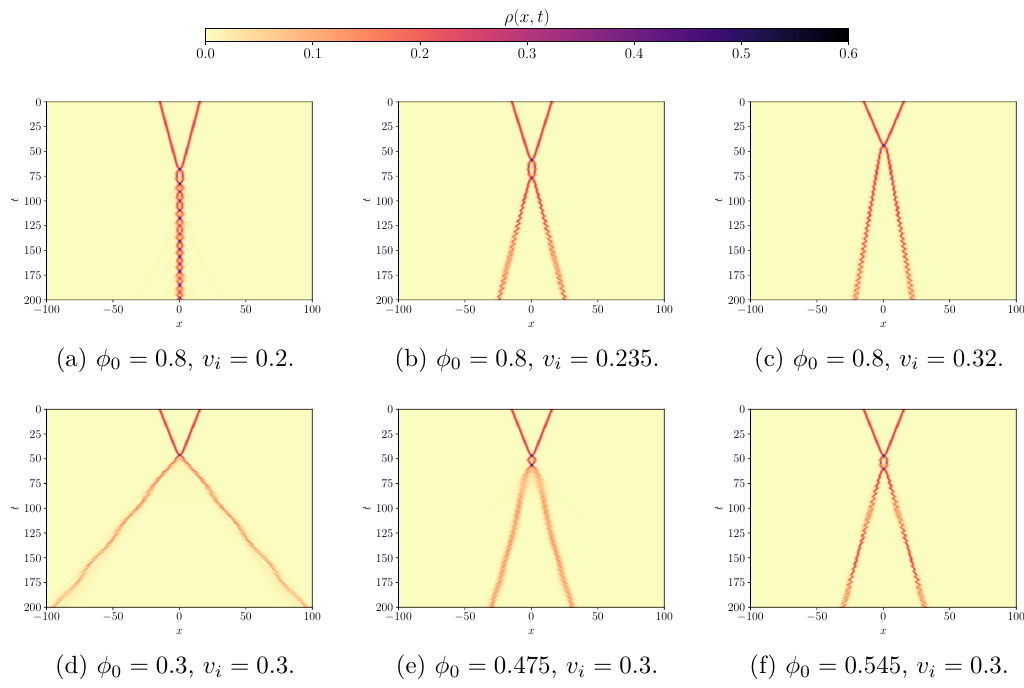
Figure 6 . Evolution of the fermion density in spacetime. We consider the attractive case where the fermions start at the zero